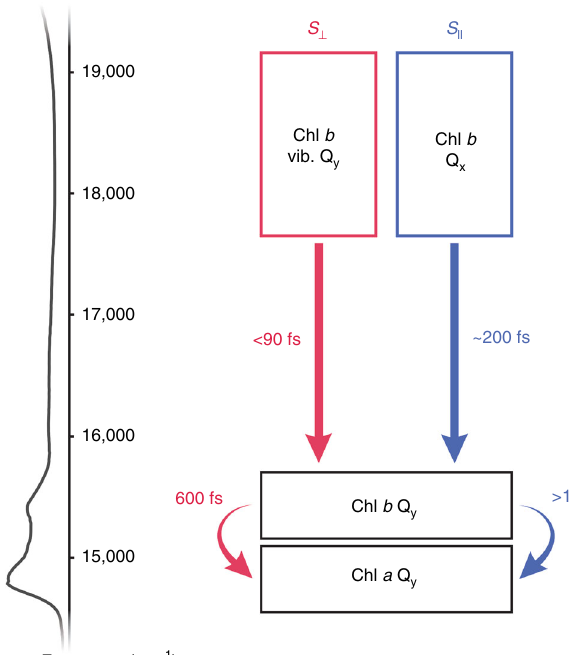
Fig. 4 Summary of observed dynamics. The region spanning 17,545 – 19,230 cm − 1 is dominated by Chl b character. Polarization- dependent 2DEV spectroscopic measurements reveal distinct, overlapping excited states of Chl b in this region, which are assigned as the vibronic Q y states (isolated in the S ⊥ spectra) and the Q x states (isolated in the S || spectra). These states also exhibit vastly different dynamics. The Chl b vibronic Q y states were found to undergo relaxation within the Chl b Q y manifold in <90 fs followed by Chl b → Chl a transfer on a timescale of 600 fs, while the Chl b Q x states were found to undergo internal conversion on a timescale of 200 fs, followed by much slower Chl b → Chl a transfer on a timescale of >1 ps (beyond the duration of the